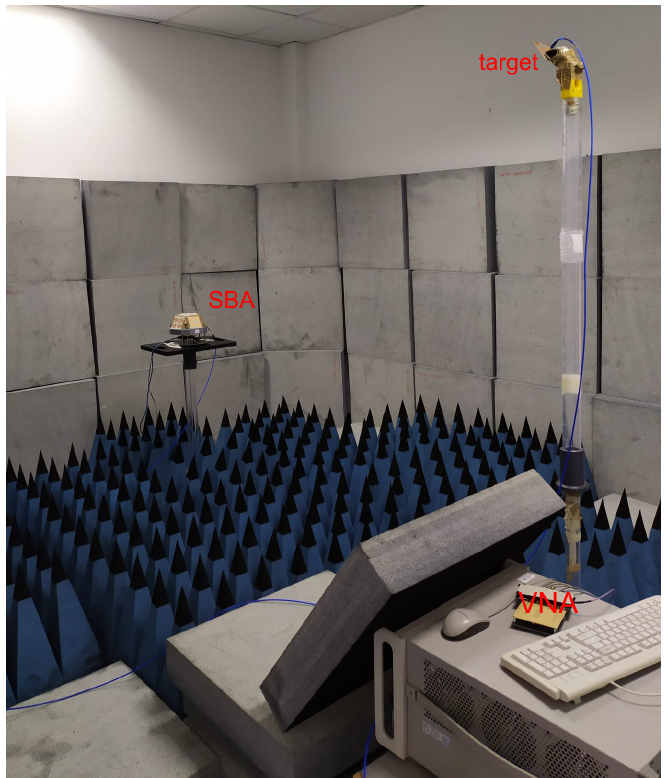
Figure 11. Picture of the experimental setup with the target positioned on a pole and the SBA installed on a rotating platform.